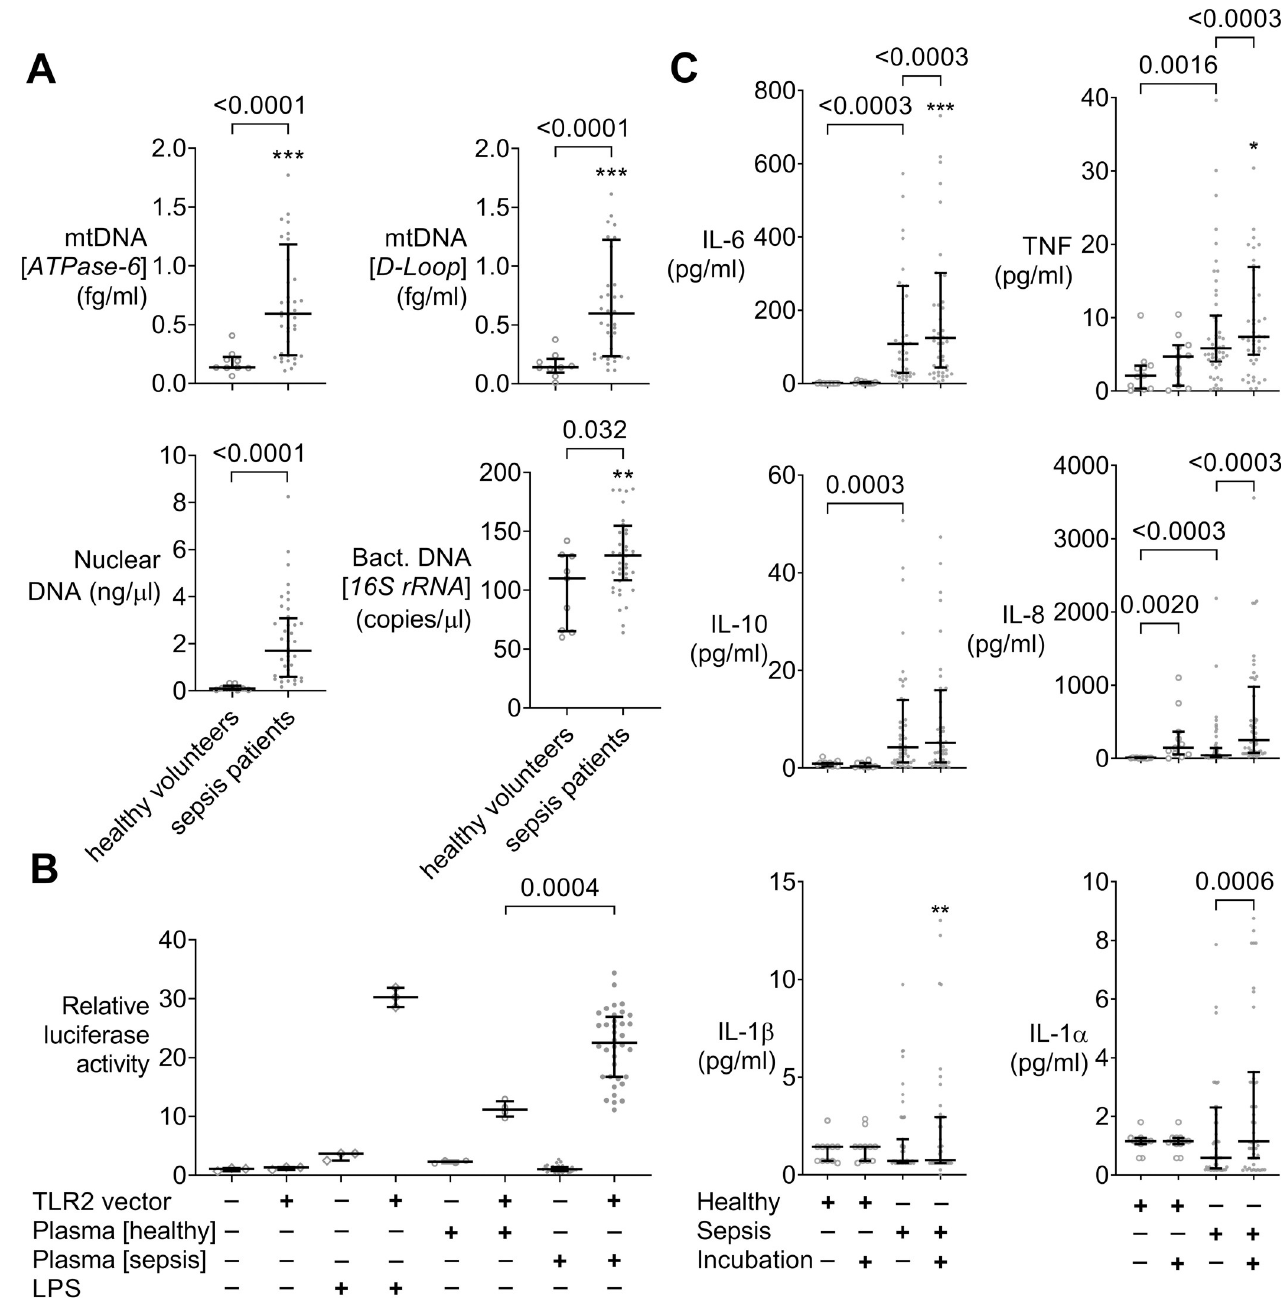
Fig 4. Circulating P/DAMPs, inflammatory activity, and ex vivo cytokine production of sepsis patients. A qPCR of plasma derived DNA preparations from 40 sepsis patients (dots) and 9 matched healthy volunteers (open circles) with primers towards host mitochondrial (mt), bacterial (bact.; r, ribosomal) coding sequences, and a human nuclear specific noncoding genomic DNA segment. Sepsis patients’ blood plasma contains greater concentrations of typical P/ DAMPs. B TLR2 and NF- κ B dependent luciferase reporter gene assay using transiently transfected HEK293 cells challenged for 16 h with plasma from 36 sepsis patients (dots) sampled within 24 h of meeting Sepsis-3 criteria or from 4 healthy volunteers (open circles). NF- κ B dependent luciferase gene in all cells. Transfection with either TLR2 gene vector or empty vector as specificity control (TLR2 vector + / -). RPMI 1640 without or with autologous plasma with or without LPS ( E . coli O111:B4) as positive and negative control (open rhombi). C Supernatant cytokine concentrations in assays of 51 patients with sepsis (dots) and 11 healthy controls (open circles) at baseline and following 6 h of incubation. As expected, inflammatory cytokine concentrations at baseline are greater in sepsis patients than controls. However, concentrations of IL-6 and TNF further increase upon 6 h of incubation in autologous plasma but not in controls. A–C � Data point out of axis limits. Dot plots with median and quartiles. Mann-Whitney or Wilcoxon matched pairs tests as appropriate with Holm-Bonferroni correction for multiple